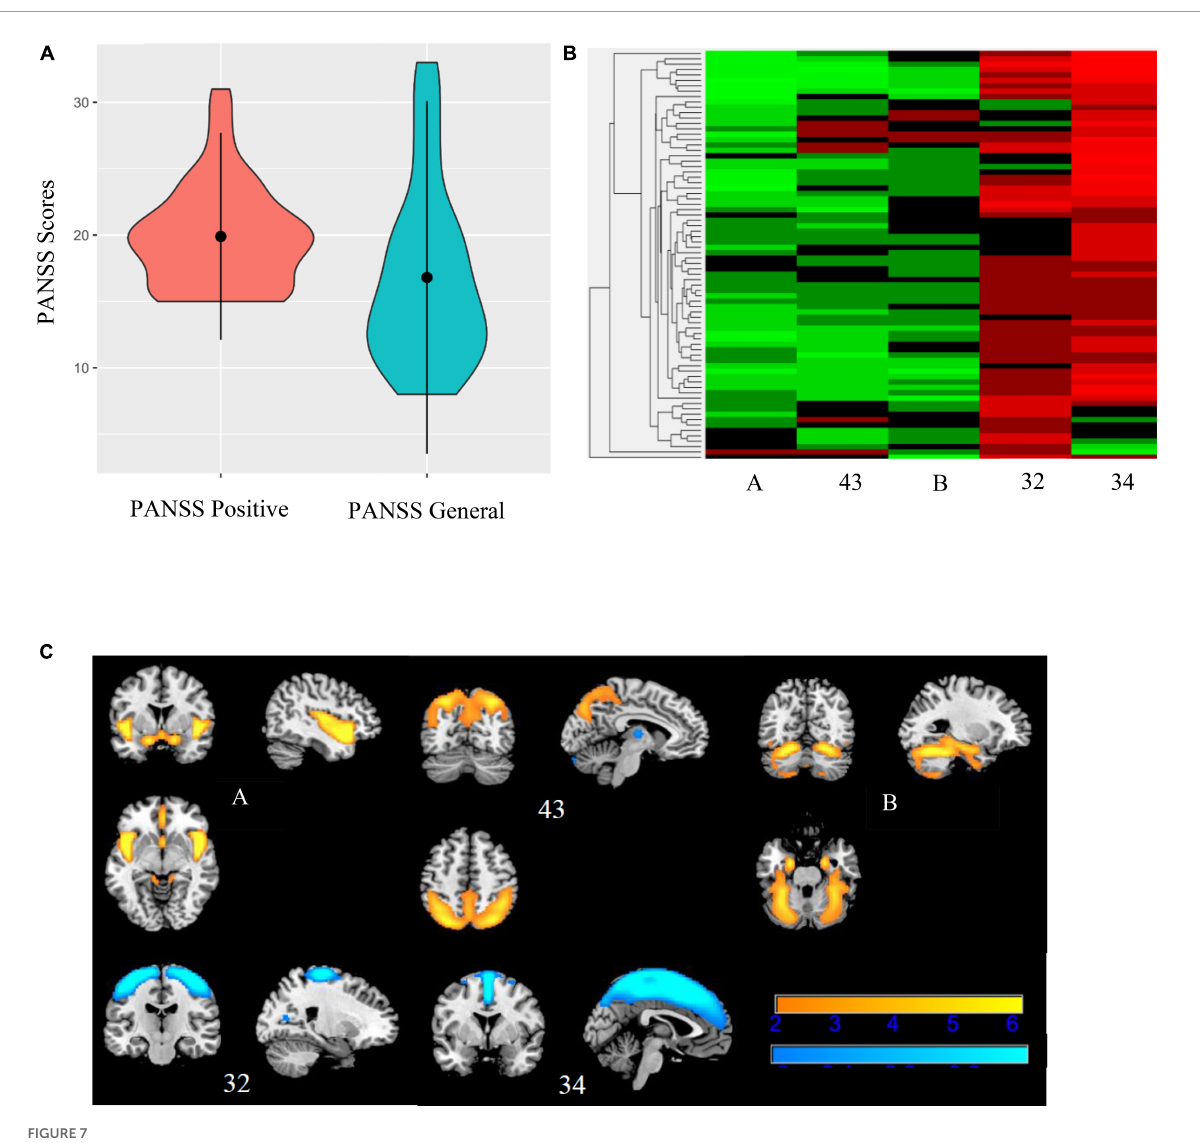
FIGURE7 Bicluster 2: PANSS scores, heat map of loadings of independent component analysis (ICA) components, and ICA components. Bicluster 2 ( N = 76) consisted of more severe PANSS positive and PANSS general scores (A) and 5 ICA components (A, 43, B, 32, and 34) representing the insula, cerebellum, and supplemental motor and motor cortices (B) . Images in (C) 7C are thresholded at |2.5|. Warm colors represent positive values and cool colors represent negative